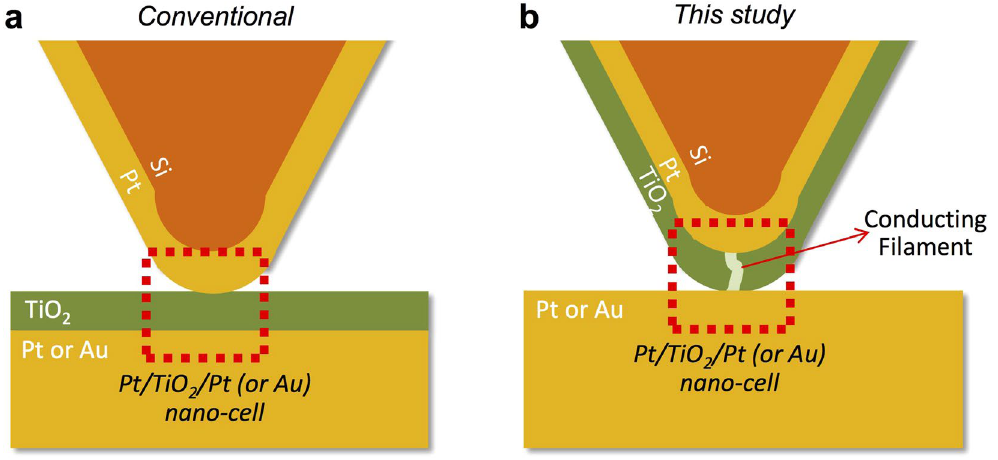
Figure 1. ( a ) The conventional and ( b ) the modified configuration (used for this study) scanning probe-based